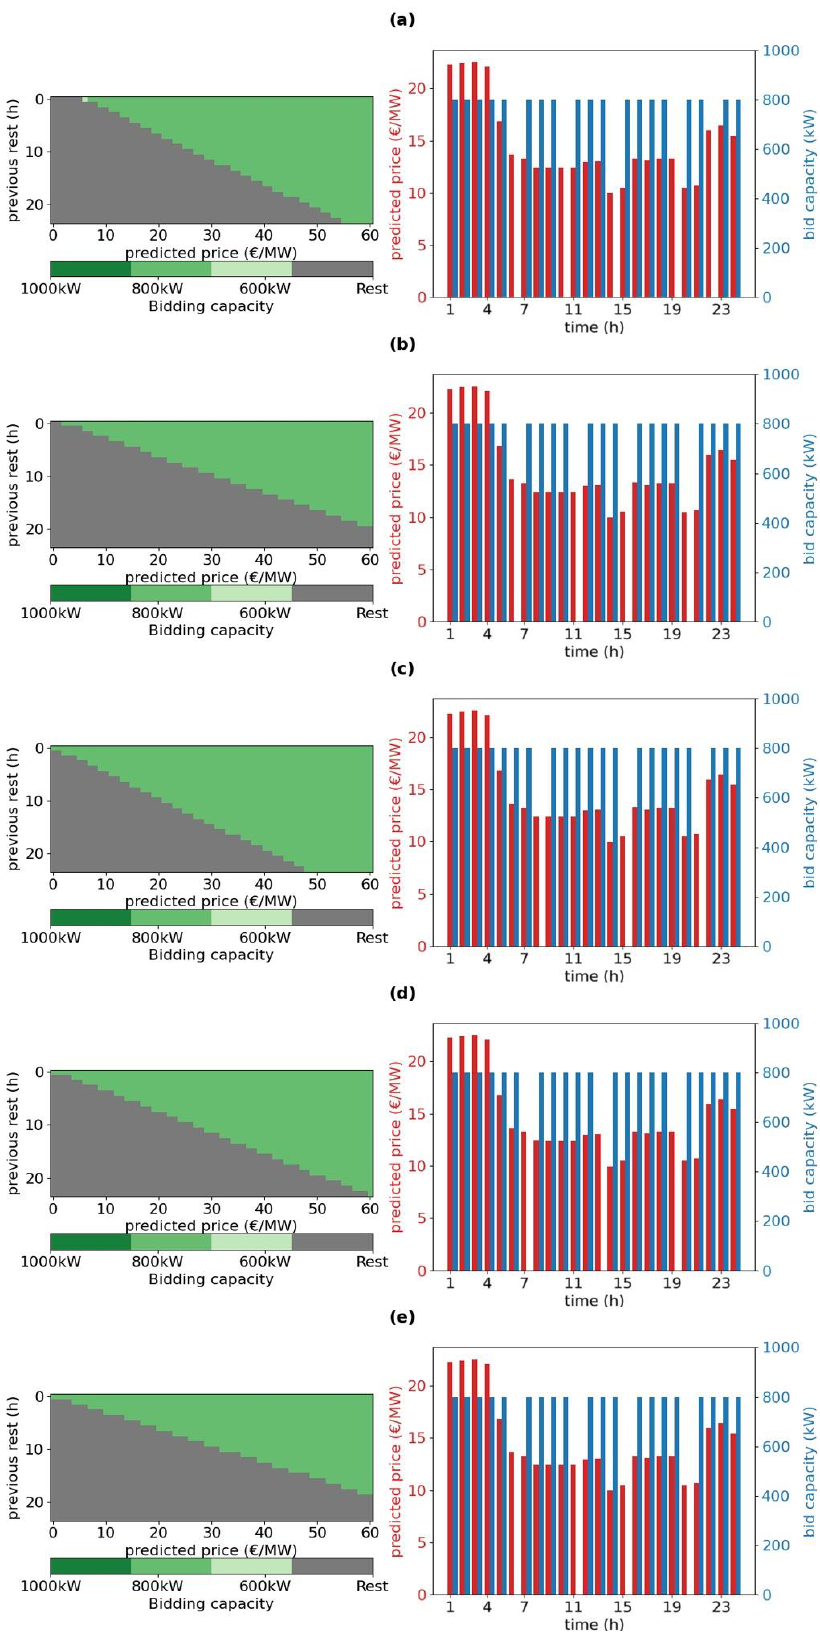
Figure 6. The actions taken by the trained reinforcement learning agent (left) and the resulting bidding behavior on 4 September 2020 (right) after epochs 2 ( a ), 4 ( b ), 6 ( c ), 8 ( d ) and 10 ( e ).